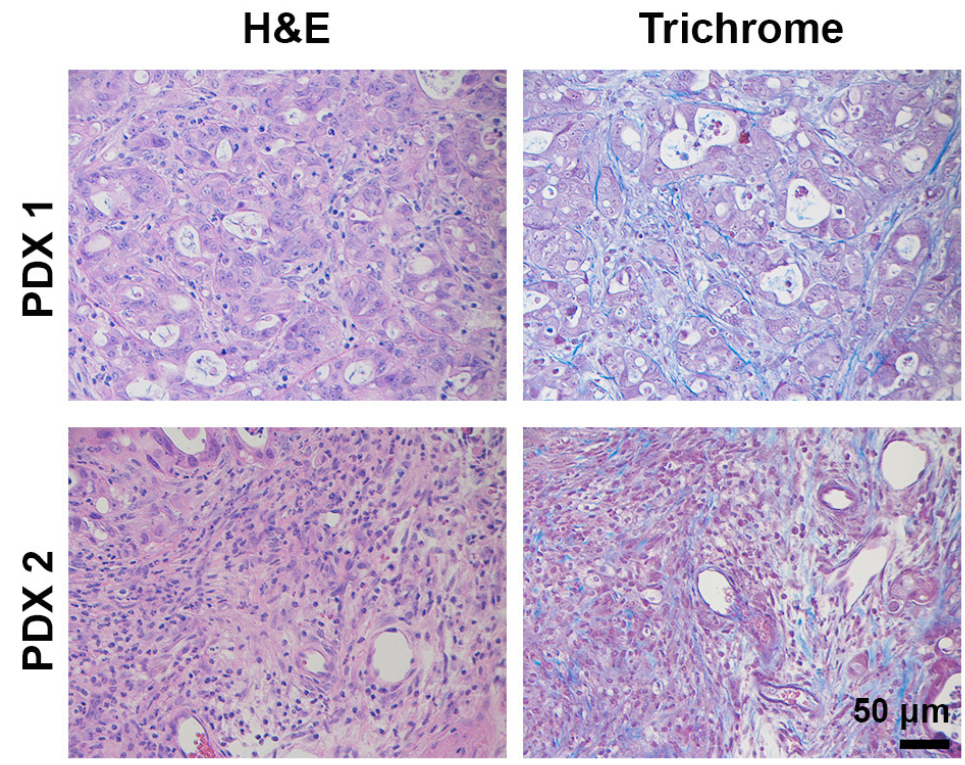
Figure 5. Desmoplasia and immune infiltration in PDAC PDX tumors. Tumors from chemo-naïve PDAC patients were established in immunodeficient mice, and passage #2 tumors were H&E and trichrome stained. Magnification, 20×.